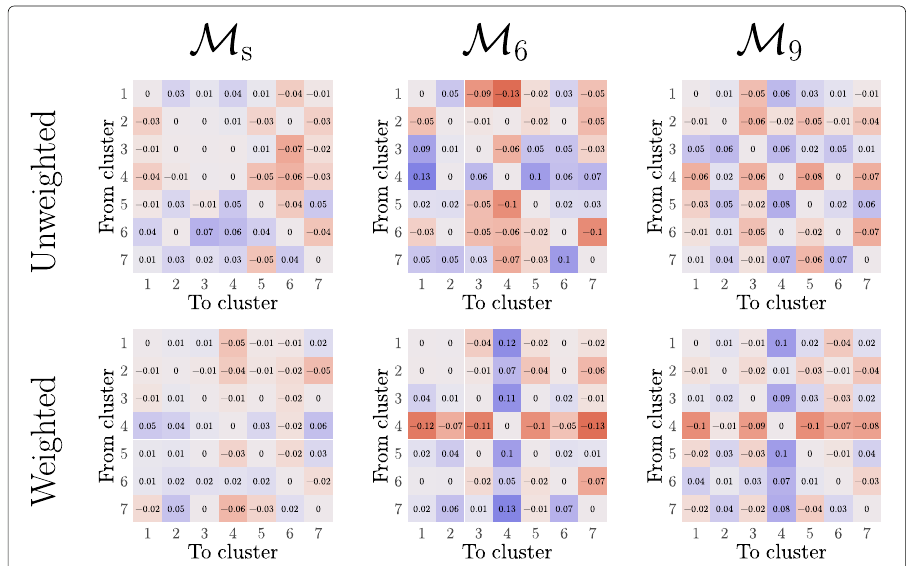
Fig. 12 Cut imbalance ratio matrices for functional motif-based clusterings of the US-M IGRATION network, for various motifs. Entry ( i , j ) is positive if most of the flow is in the direction i → j . Top row: clusterings from the unweighted graph. Bottom row: clusterings from the weighted graph. M s corresponds to using the symmetrized adjacency matrix